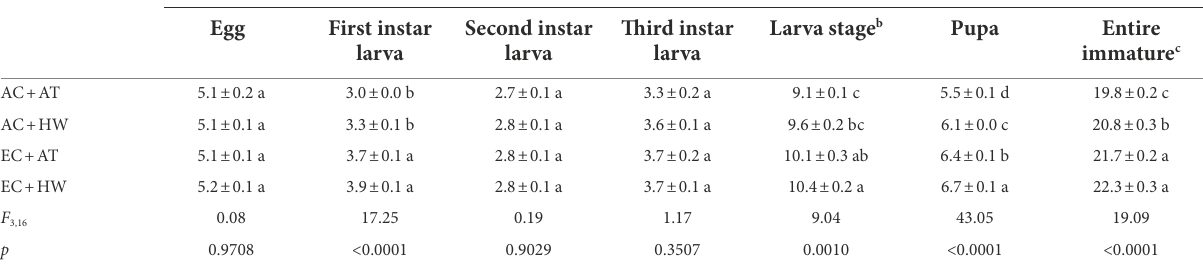
TABLE 1 Effect of different stages of Ophraella communa by feeding on common ragweed after treatment on development period. Treatment